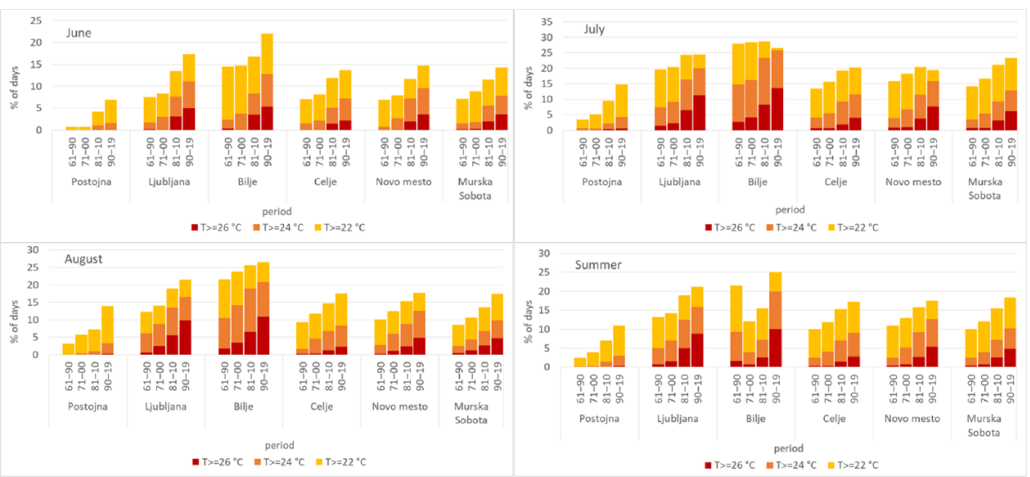
Figure 3. The percentage of days in summer (June‒August) with average daily air temperature higher than or equal to the threshold (22 ◦ C—yellow, 24 ◦ C—orange and 26 ◦ C—red) in four periods (1961–1990